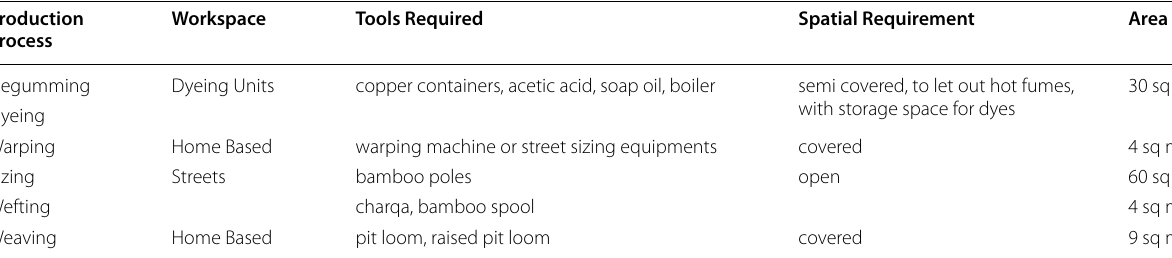
Table 1 Spatial requirements for various processes involved in weaving Production